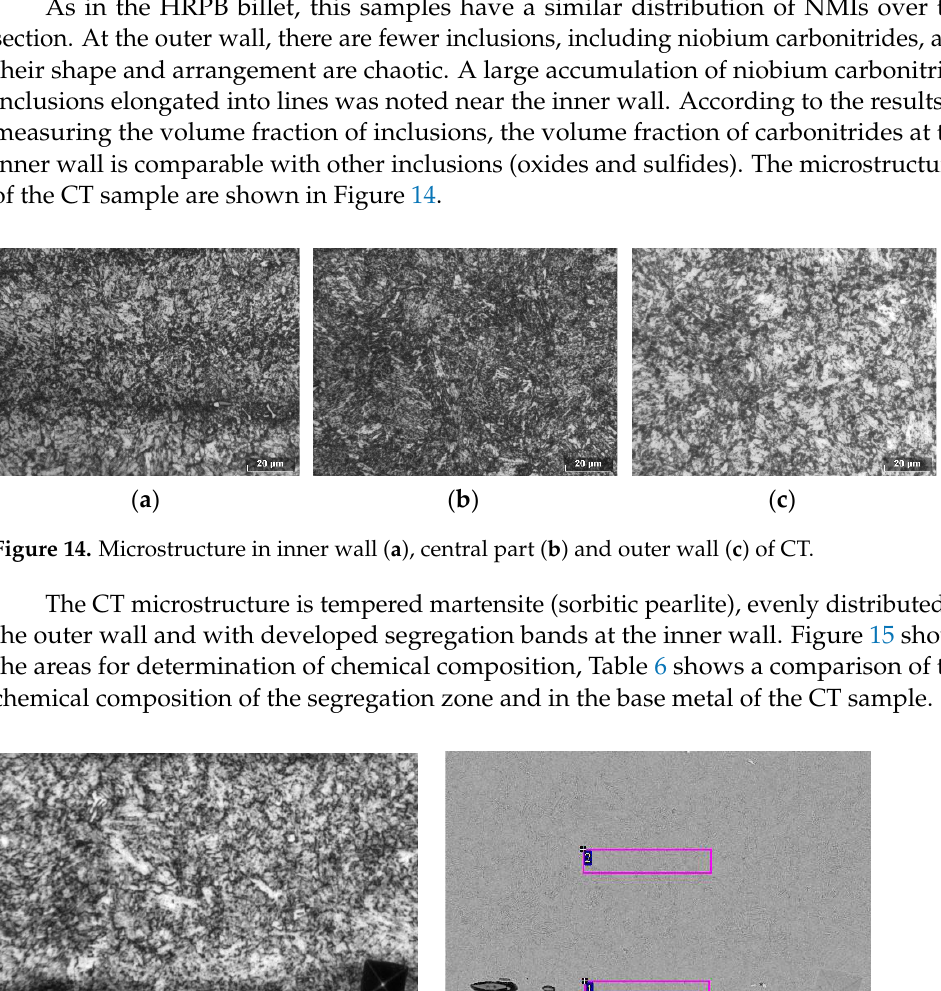
Figure 13. Distribution of microhardness on cross-section of the wall of casing tube (CT).